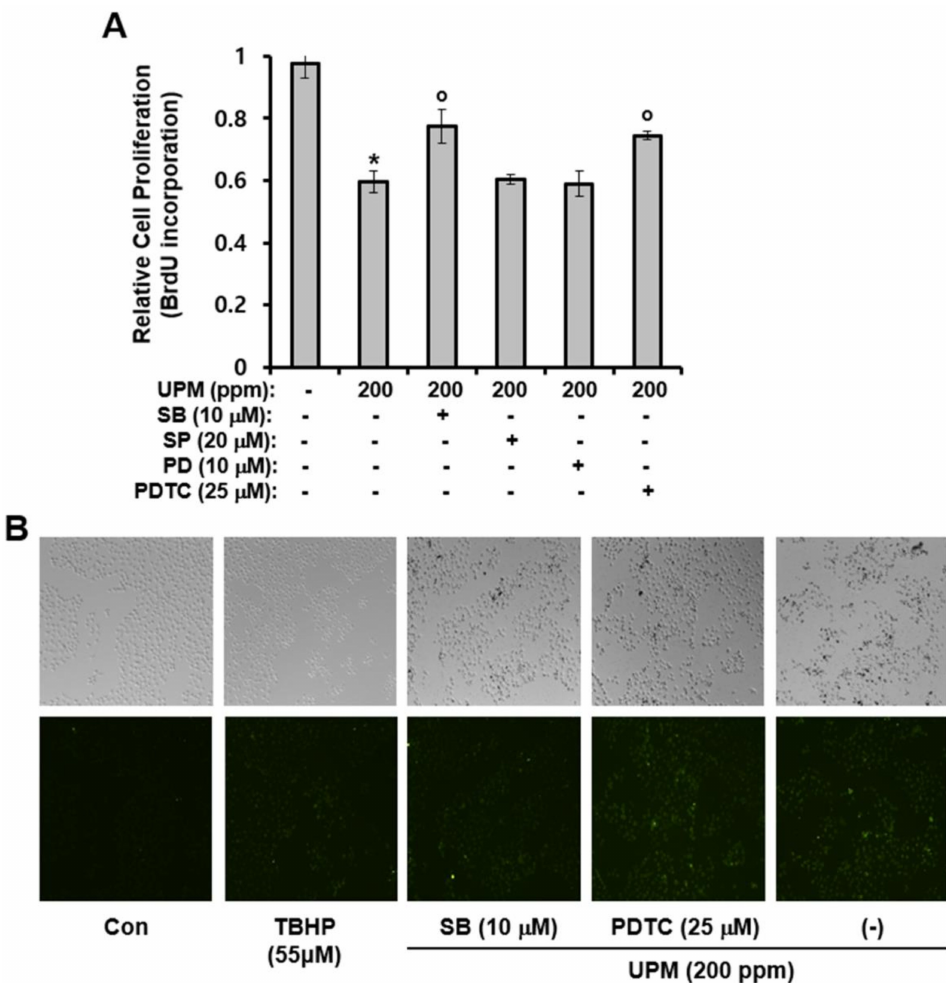
Figure 6. UPM-induced effects on cell proliferation and ROS production in HaCaT cells. ( A ) HaCaT cells were treated with the indicated concentrations of UPM and then incubated for two days in the presence of the indicated concentration of inhibitors. The results were verified using three independent experiments, each of which was conducted in duplicate. * p < 0.05 vs. the untreated control, o p < 0.05 vs. the UPM-treated control. The data are expressed as the mean ± SD. ( B ) HaCaT cells were treated with UPM (200 ppm) and then incubated for two days in the presence of the indicated concentration of inhibitors. ROS production was evaluated using 2’,7’-dichlorofluorescein diacetate. UPM, urban particulate matter; SB, SB203580; SP, SP600125; PD, PD98059; PDTC, ammonium pyrrolidinedithiocarbamate; TBHP, tert-Butyl